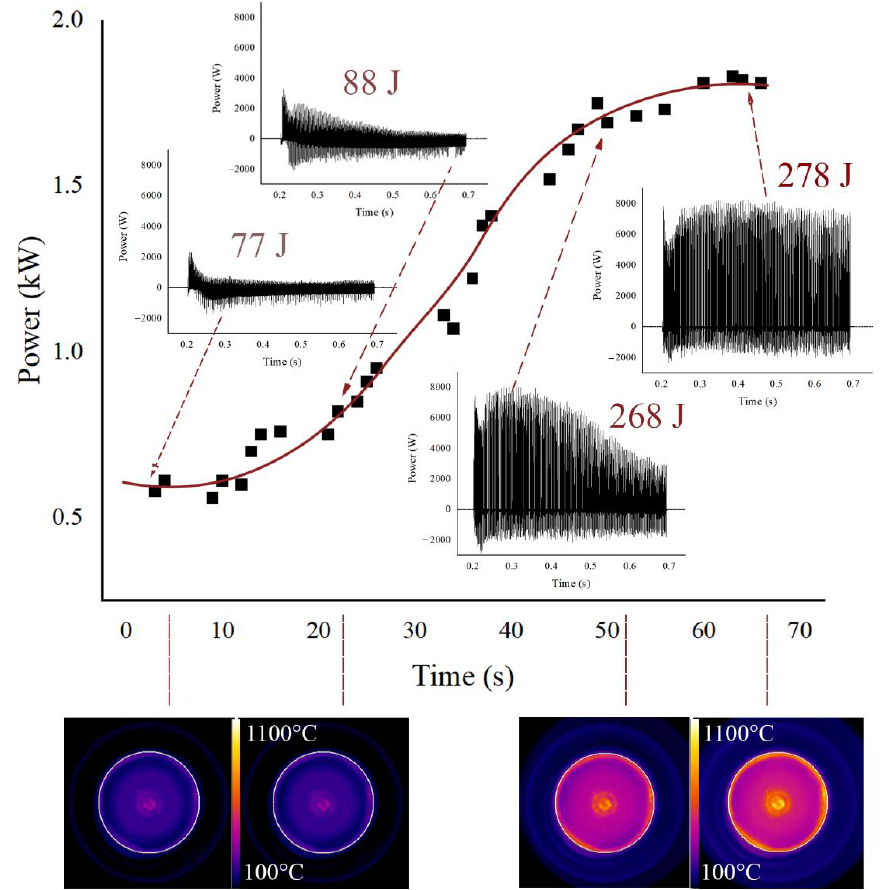
Figure 2. Diagram presenting the evolution of glow discharge power during the sputtering of hot nickel target and images of temperature distribution on the target surface .